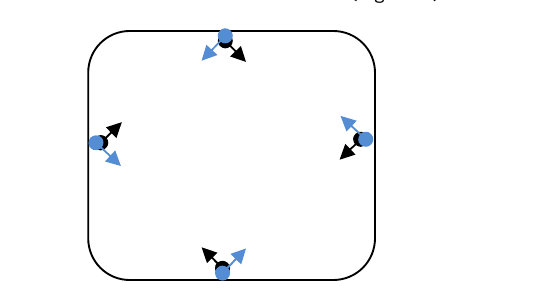
Figure 8. photography positions for a room.